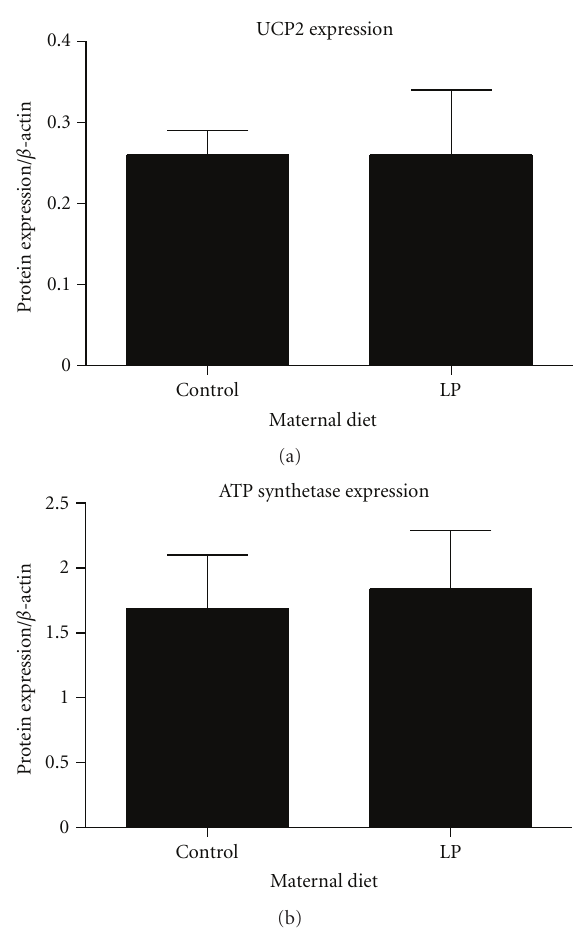
Figure 6: Expression of UCP2 and ATP synthetase β -subunit, determined by Western blot. Protein expression of UCP2 and ATP Synthetase β -subunit were unaltered by maternal protein restriction. Values are means ± S.E.M. n = 5 animals per group.